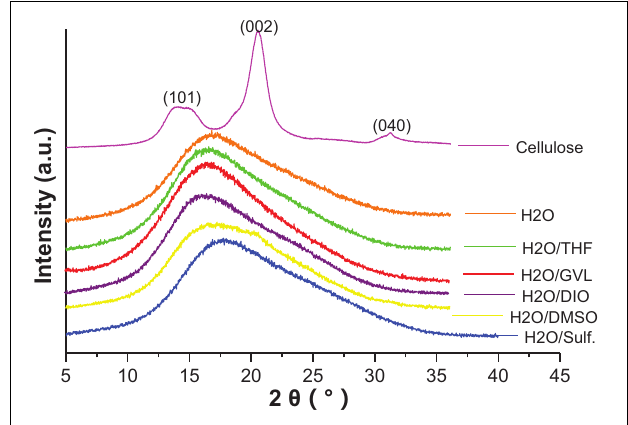
FIGURE 4 | X-ray diffraction patterns of cellulose and solid residues after reactions with different biphasic solvent systems.